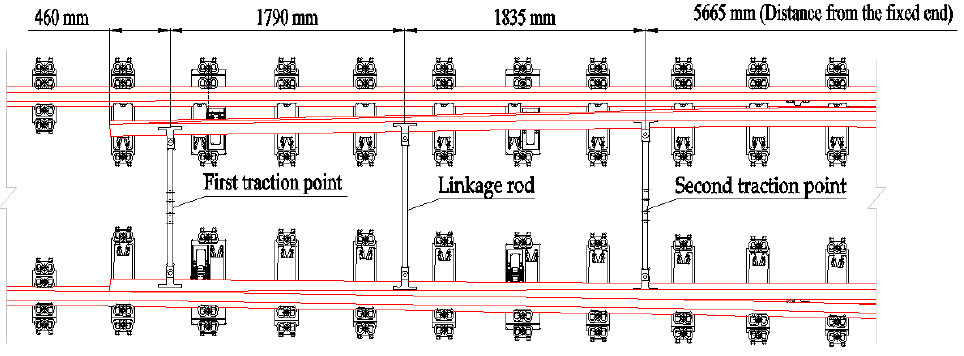
Figure 1. Design scheme for joint internal locking.